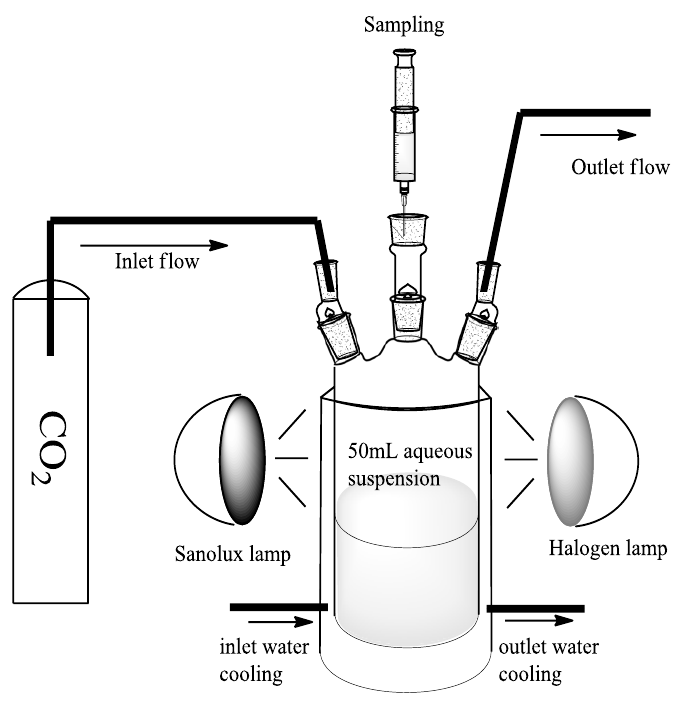
Figure 8. Experimental